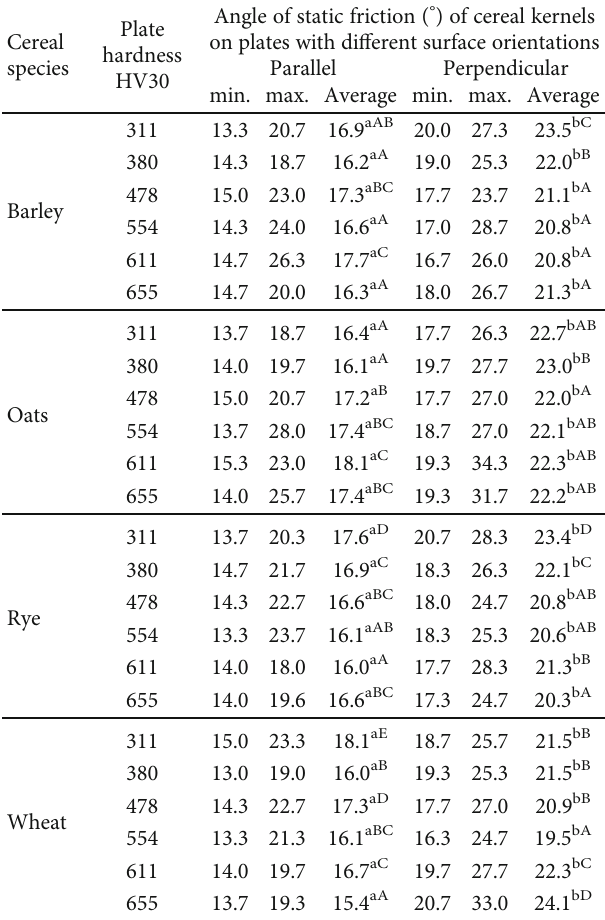
a Mc values are based on three replications. The remaining parameters are based on 50 replications. Table 3: The angle of static friction of cereal kernels and the signi fi cance of di ff erences in angle